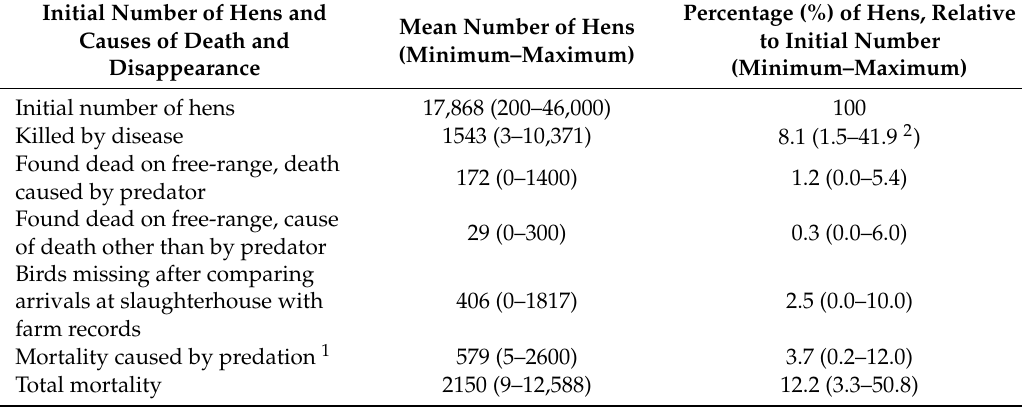
Table 7. Causes of death of chickens in the last culled flock on organic / free-range